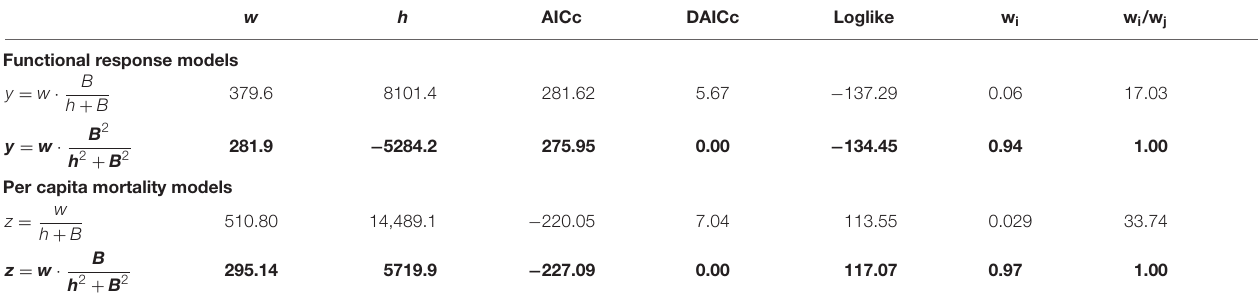
TABLE 1 | The behavioral responses of the fishery to changes in jack-mackerel stock biomass. w h AICc DAICc